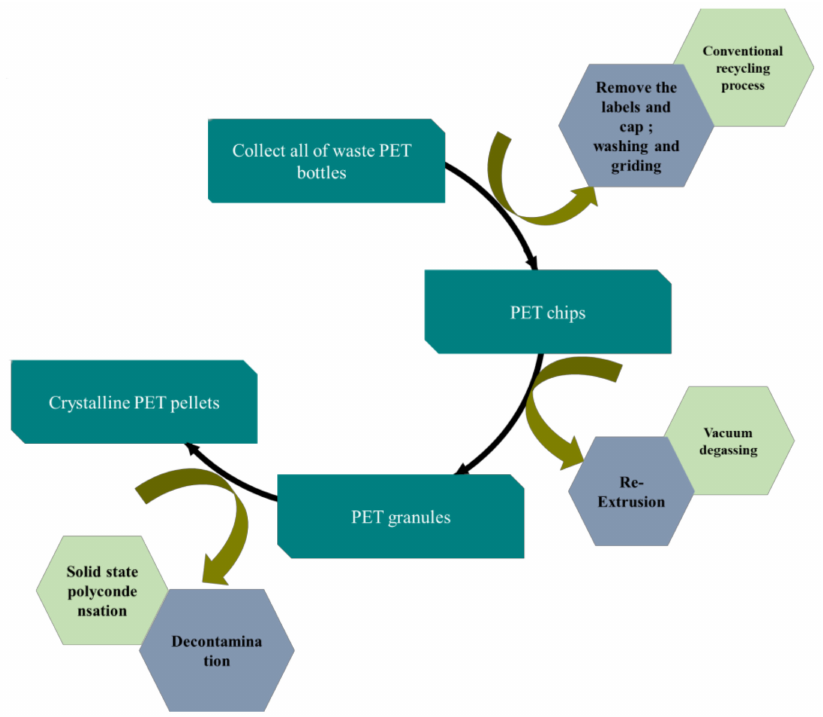
Figure 2. Scheme of PET super-clean recycling processes based on bottle–chip–granule–pellet, and mechanical